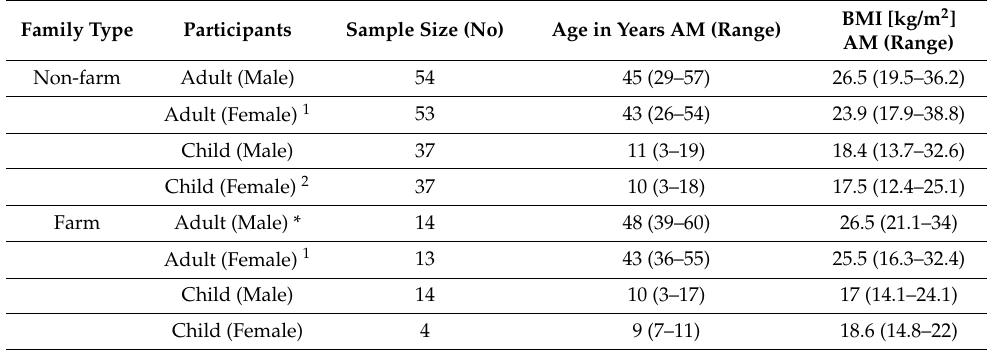
Table 1. Participant information: personal and demographic characteristics. Data are presented as a number of observations or mean values (range) for parameters on a continuous scale.